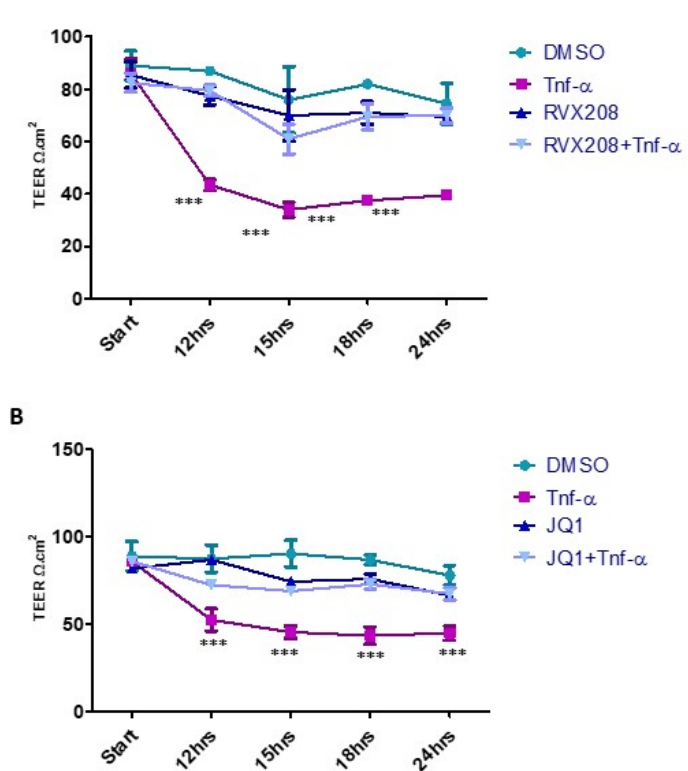
Figure 6. BRD4 inhibition protects monolayer integrity in HUVECs. ( A , B ) HUVECs grown on a 0.45 µ M transwell membrane for 5 days to establish intact monolayers. HUVECs are treated with DMSO, TNF ‐α‐ only, JRVX208/JQ1 ‐ only, and JQ1/RVX208, followed by TNF ‐α . Line graph shows TEER measured in HUVECs monolayer, treated with DMSO and TNF ‐α for 12 h. Two ‐ way ANOVA with Bonferroni’s post ‐ test used. Values are mean ± SD of three biological replicates (*** = p < 0.001).